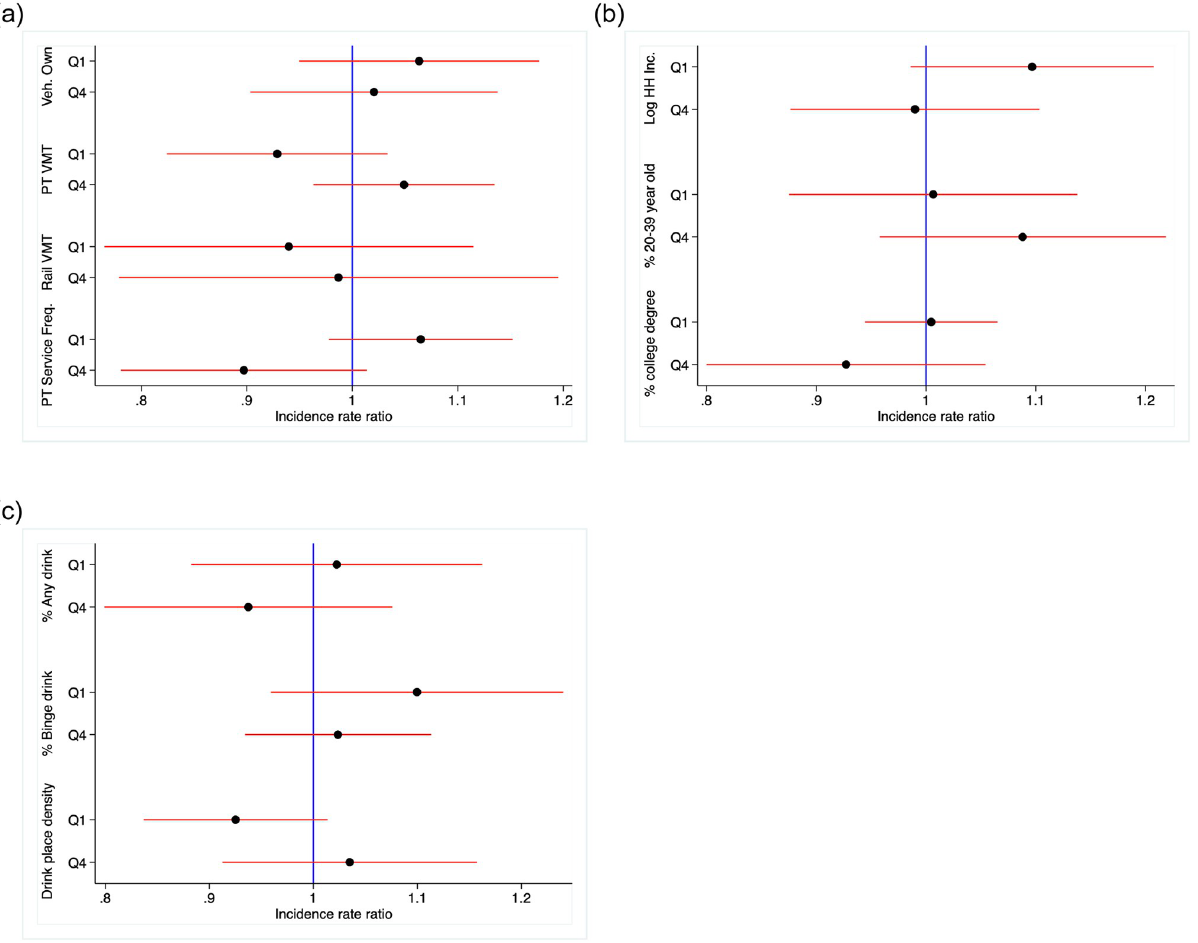
Fig 2. Incidence rate ratios for the association of uber availability and alcohol–involved traffic fatalities by top and bottom quartile on county characteristics, principal counties of the largest 100 US metropolitan areas, 2009–2017. (a) Public transit access and vehicle ownership, (b) Demographic and socioeconomic characteristics, and (c) Alcohol access and